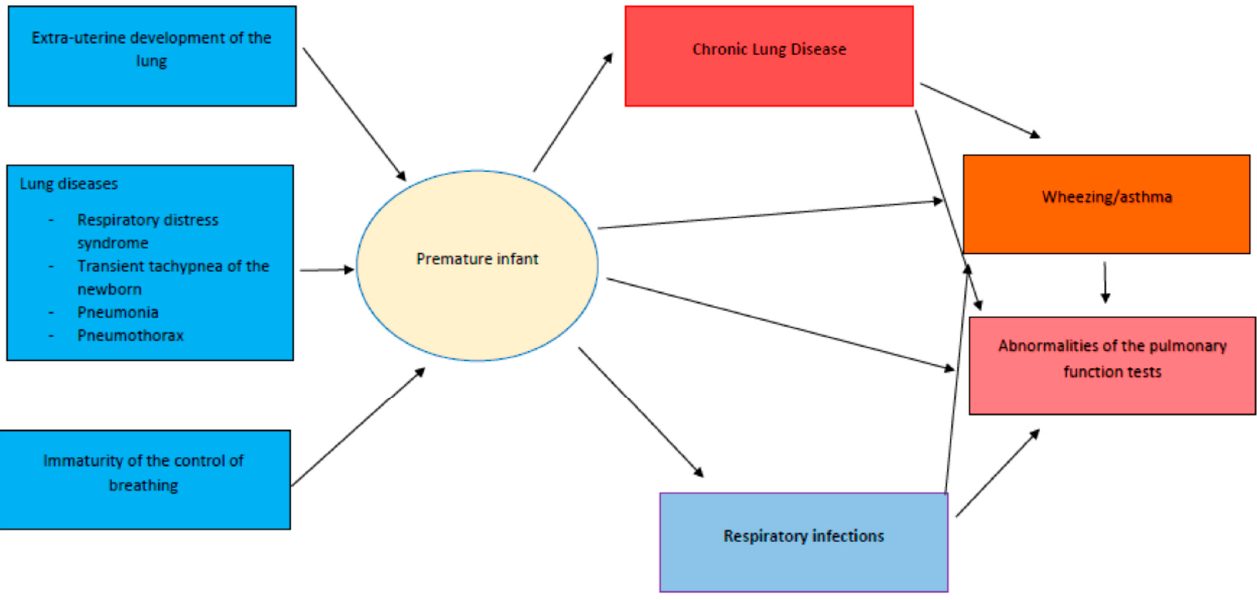
Figure 2. Respiratory consequences of